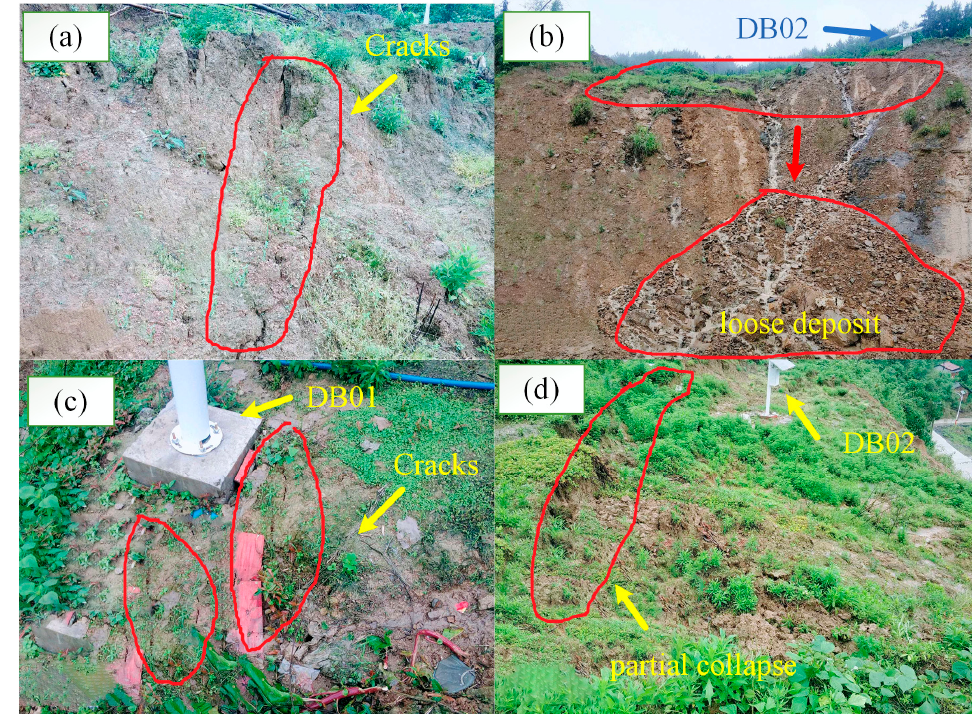
Figure 4. On-site inspection photos on 19 May 2021. ( a ) Long cracks on the surface of the landslide. ( b ) Loose deposit near the DB02 station. ( c ) Multiple cracks near DB01 station. ( d ) partial collapse near DB02 station.